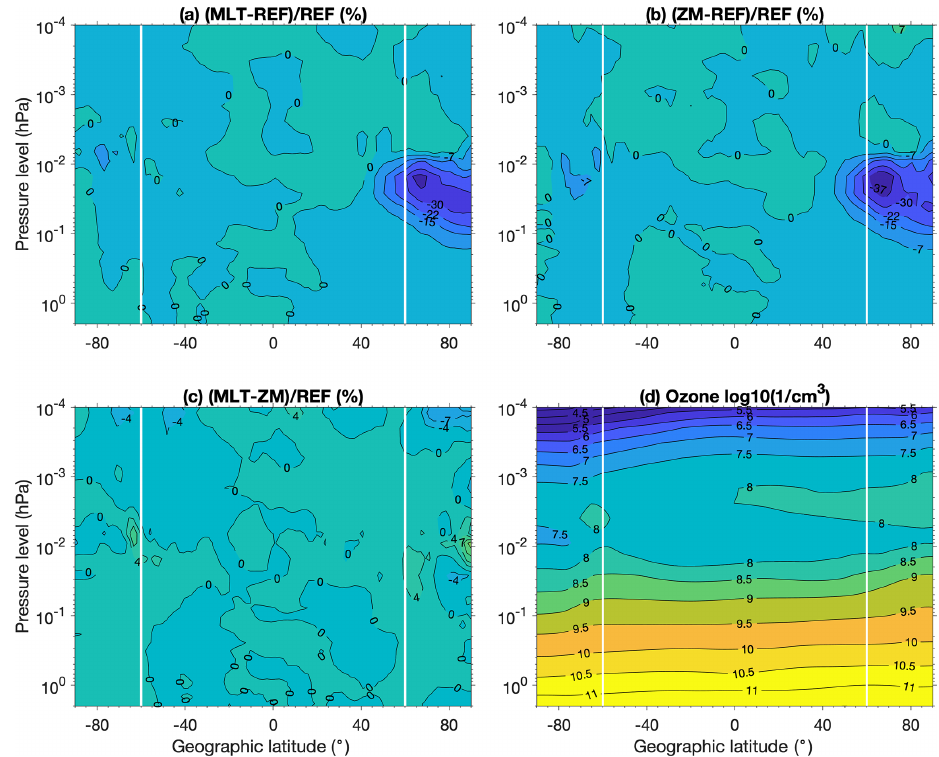
Figure 5. February monthly-mean zonal-mean ozone from the extreme-case simulation. Panels (a) – (d) are as in Fig. 3. White vertical lines mark the ± 60 ◦ in geographic